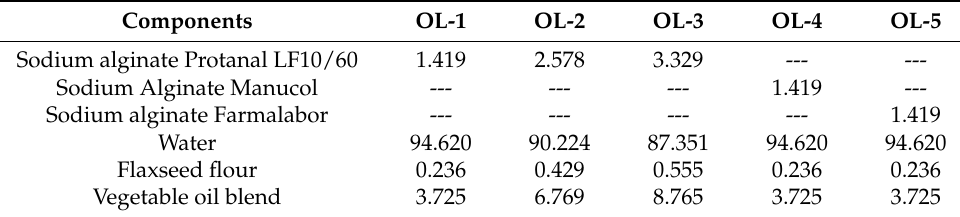
Table 6. Percentage composition of placebo emulsions prepared in the preliminary